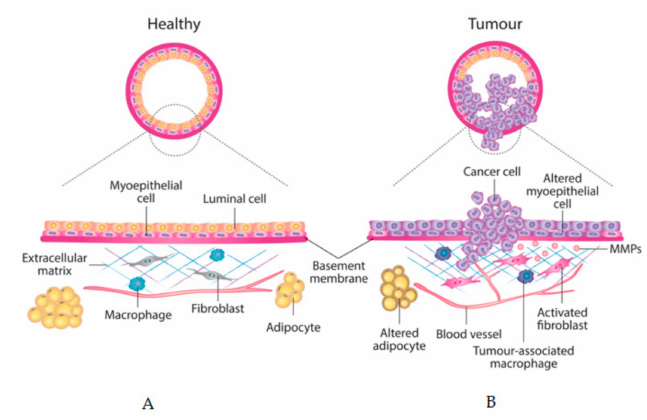
Figure 2. Schematic model of breast epithelium and its stroma. Major changes in cell types and in extracellular matrix (ECM) between: ( A ) healthy mammary gland and ( B ) invasive breast carcinoma are